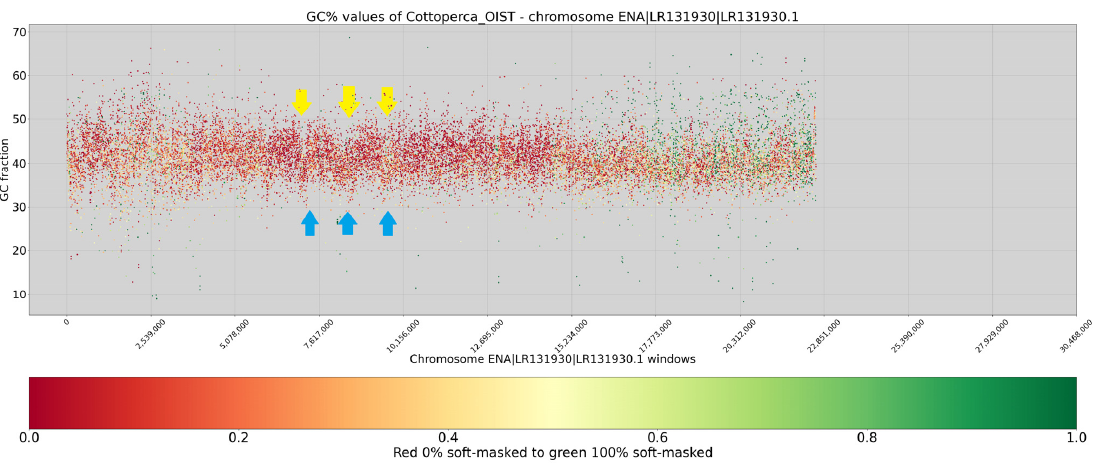
Figure 3. GC% profile of chromosome 22 in C. gobio (or LR131930 in ENA). x -axis, sequences in base pairs (bp); y -axis, GC%. The sliding window size is 1,000 bp. Yellow arrows mark several selected decreases in GC%, forming drops in the profile, and blue arrows mark “protrusions” towards lower GC% values corresponding to the drops. Similarly, increases in GC% (e.g., between the labelled drops) are accompanied by shifts towards higher GC% values.